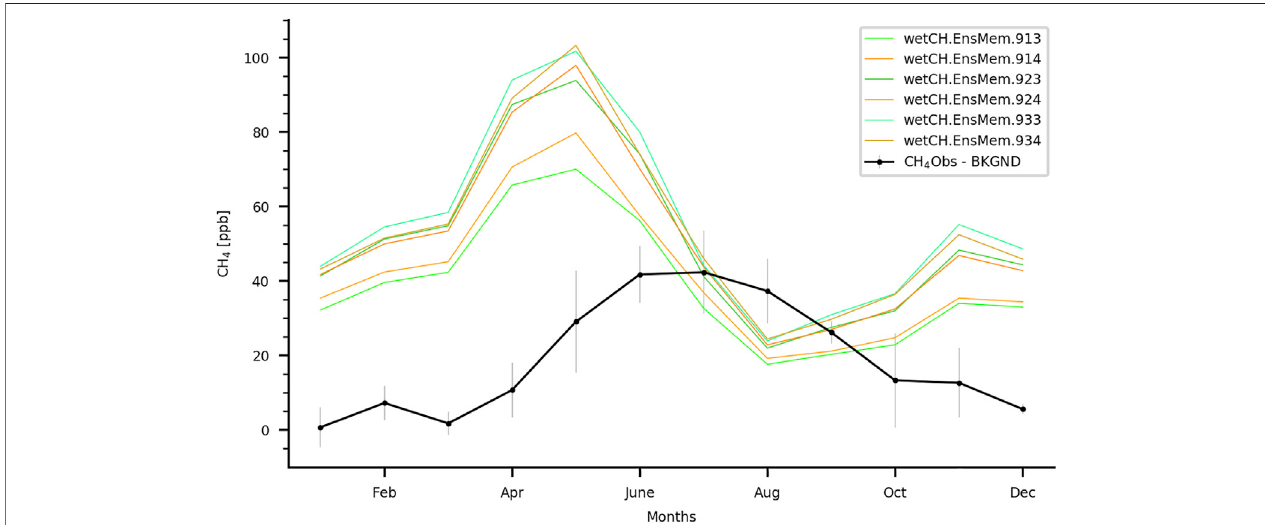
FIGURE 5 | Seasonal cycle of the regional signal (as measurements - background concentration) for simulated and observed mixing ratios of CH 4 at ATTO, expressed as parts per billion (ppb). The observed mixing ratios at ATTO (measurement height 79 m) are shown as a black line and the error bars represents ±1 sigma (standard deviation). This methodology was applied for CO 2 at ATTO by Botía et al. (2021). The background concentrations are from the inversion available via the Copernicus Atmosphere Monitoring Service (CAMS) (Segers and Houweling 2020). For the simulated and observed mixing ratios, only daytime values (13:00 – 17: 00 h local time) were used to ensure well-mixed conditions in the planetary boundary layer. WetCHARTs v1.3.1 is used for the simulated contribution of wetlands to the integrated CH 4 signal at ATTO. The set of WetCHARTs ensemble members show different temperature dependence factors for the CH 4 respiration fraction (Q 10 ) and different wetland